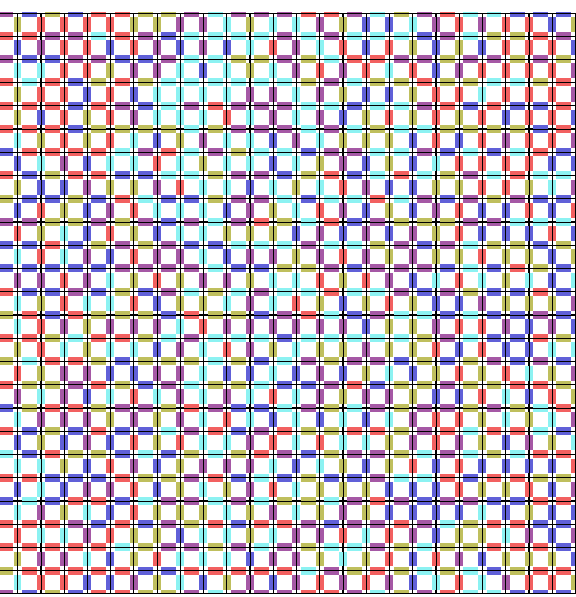
Figure 10. Periodic packing of a complete set of 625 tiles over 5 colors.